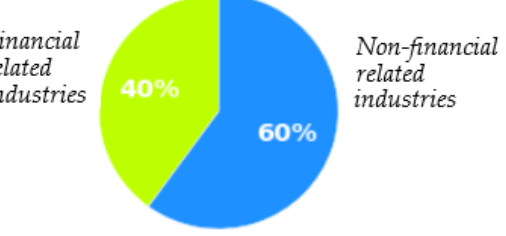
Figure 2. Respondents for question of are you working in the financial related industries? A total of 67% of the respondents held a bachelor’s degree or higher, while the other 33% held a lower degree (Figure 3, Table A4).